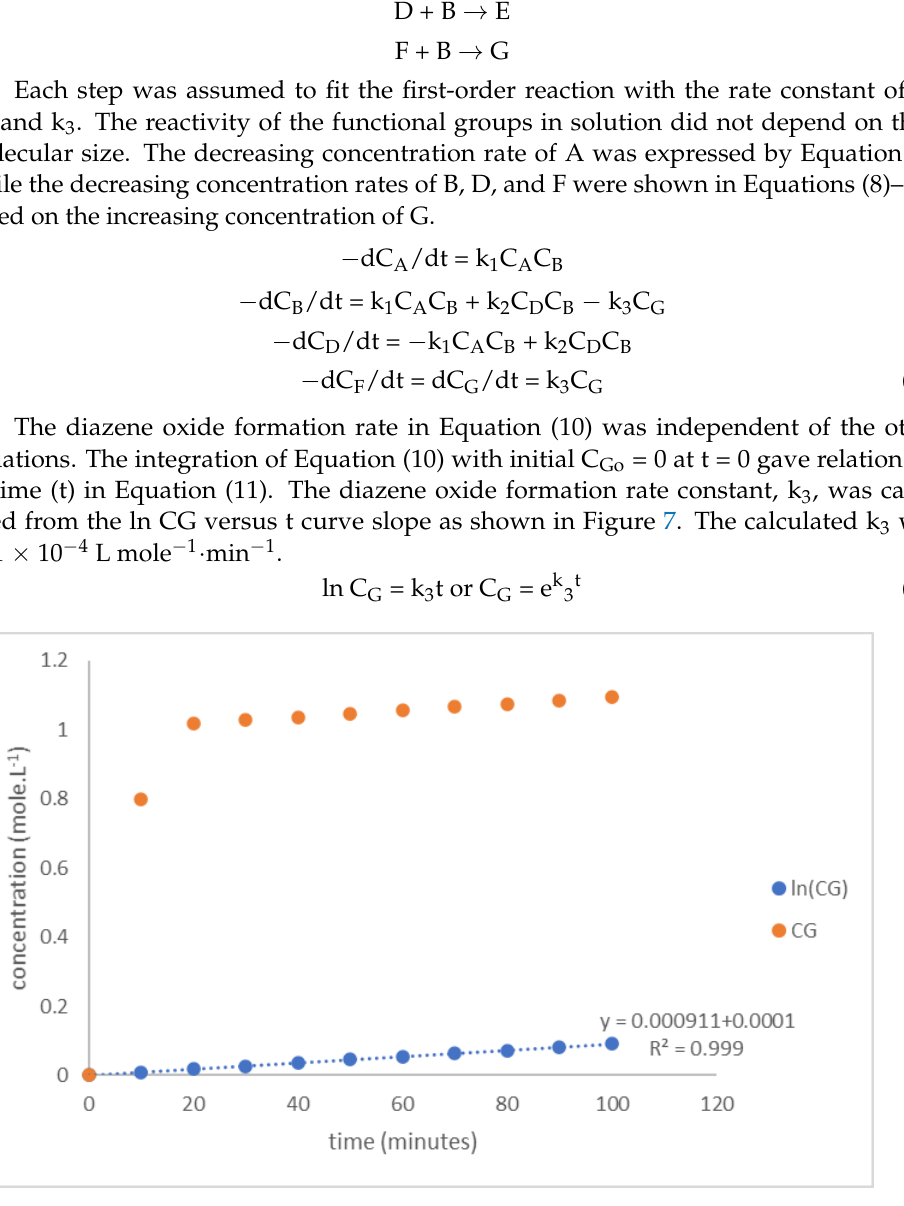
Figure 7. Curve ln C G versus t of hexogen coating with TDI. Equations (12) and (13) show the mole balance of hydroxyl groups (A) and isocyanate groups (B) at a specific reaction time, where C Ao and C Bo are the initial concentration of A and B, respectively.